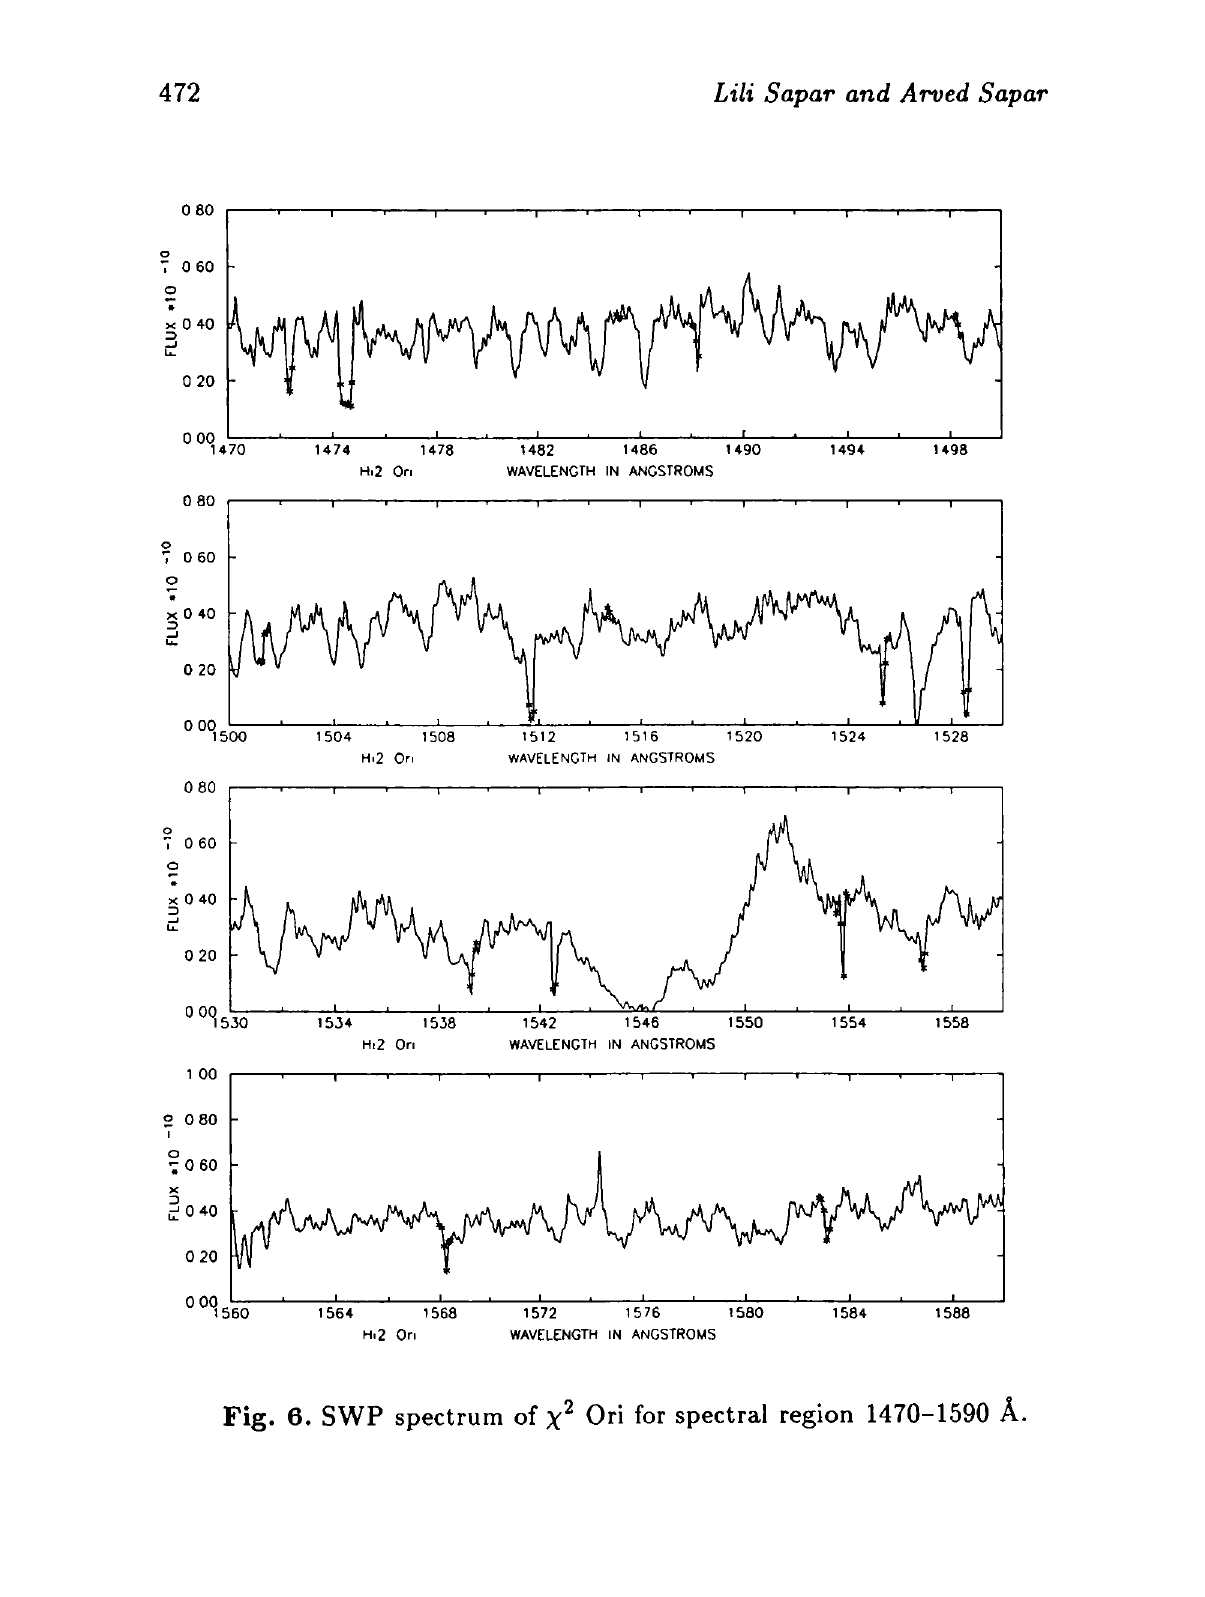
Fig. 6. SWP spectrum of x 2 Ori for spectral region 1470-1590